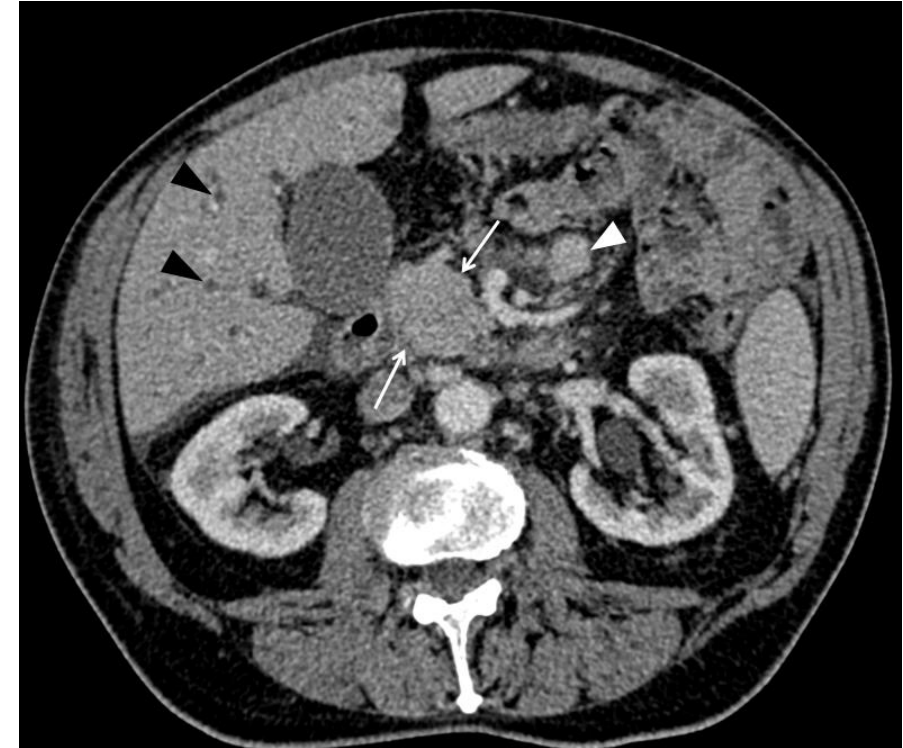
Figure 3. Computed tomography (CT) examination in a 73-year-old man with history of lung adenocarcinoma treated by surgery three years before. The patient was referred for progressive jaundice. No local recurrence of primary lung cancer was found. CT image of the abdomen in the axial plane obtained during the portal venous phase of enhancement shows homogeneous, purely solid mass (arrows) of the pancreatic head in association with intrahepatic bile duct dilatation (black arrowheads), ascites and enlarged mesenteric lymph node (white arrowhead). Endoscopic ultrasound-guided biopsy of the pancreatic mass revealed metastasis from lung adenocarcinoma.